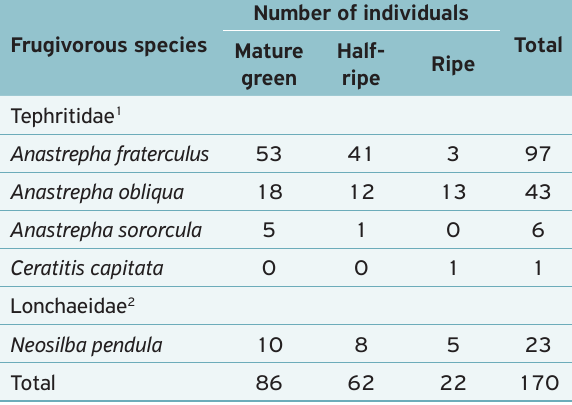
Table 1. Frugivorous fly species (Diptera: Tephritidae and Lonchaeidae) emerged from Surinam cherry of three maturation stages. Maceió, Alagoas, from October 2010 to January